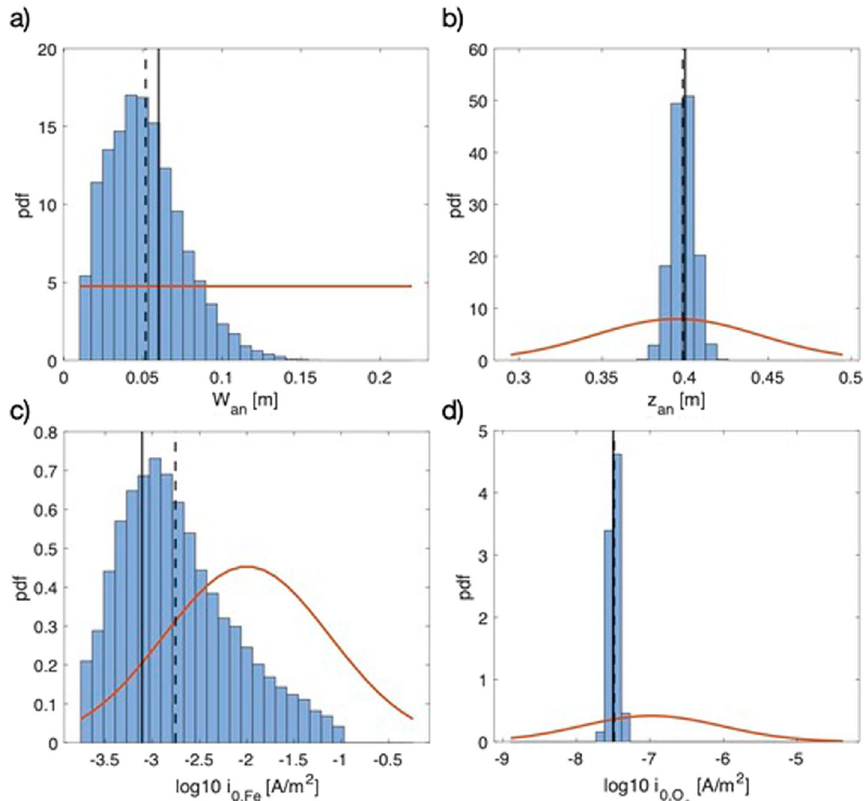
Fig. 4 Successful solving even with imprecise prior knowledge. MCMC results for simulations with M = 9 and a shifted prior probability distribution for log10( i 0,Fe ). The blue histograms show the probability density function (pdf) estimate of the MCMC results for parameters Þ with the corresponding prior probability densities (in red). The vertical lines represent the known a W an , b z an , c log10( i 0,Fe ), d log10 ð i 0 ; O 2 ground truth values, the dashed lines the mean of the MCMC